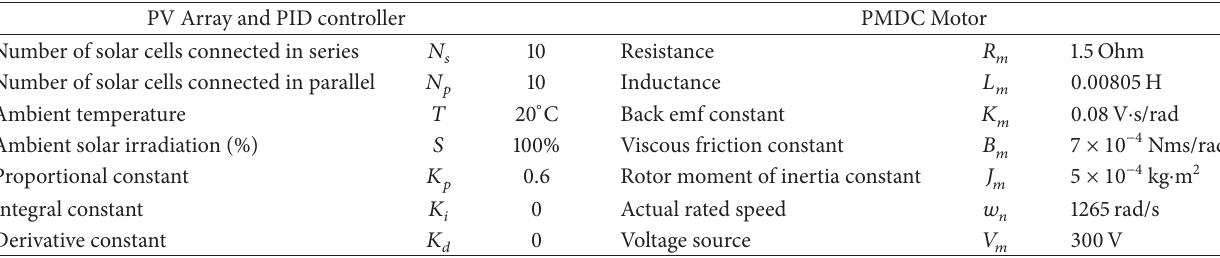
Table 3: The PV powered PMDC motor GUI interface parameters.